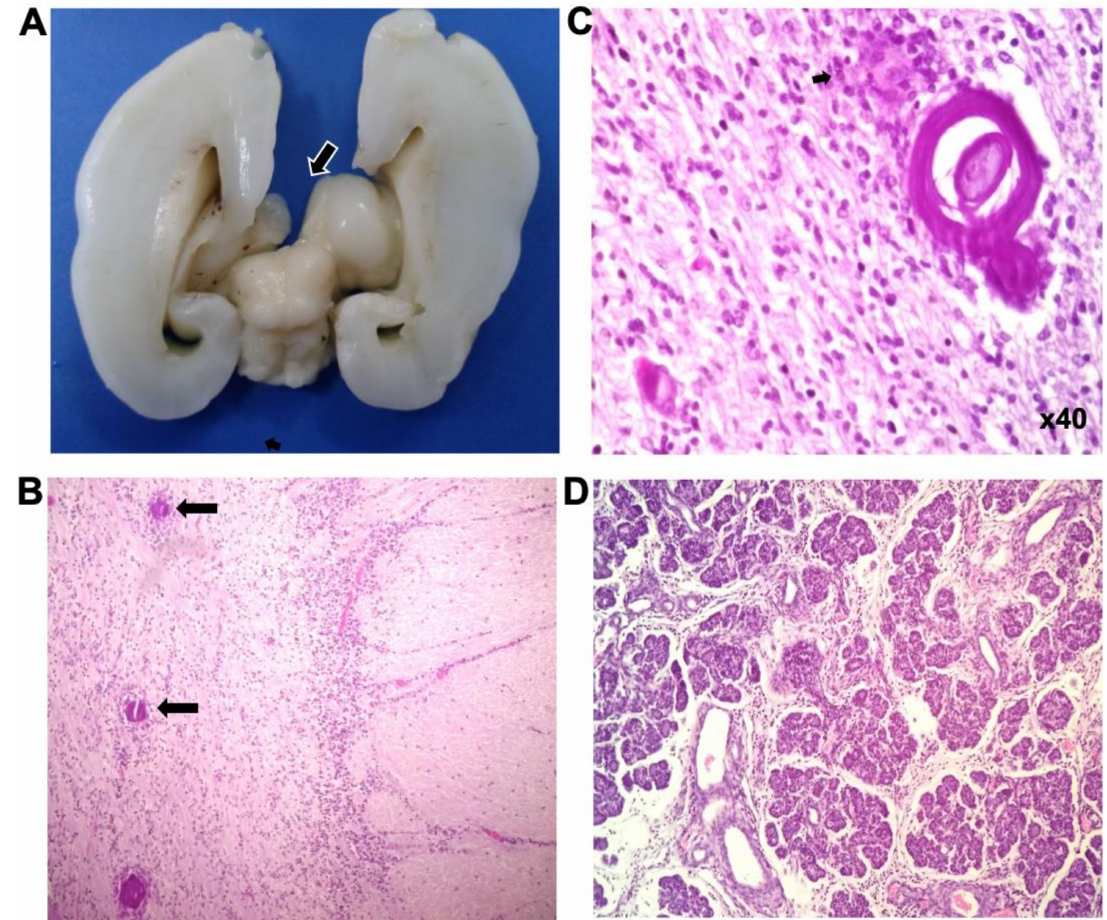
Figure 3. Anatomopathological findings of case 2. ( A ) Brain section showing corpus callosum agenesia. ( B ) Histological analysis of brain sections revealed brain parenchyma with disorganized cortex layers, and zones with laminated microcalcifications (arrows). ( C ) Neuropile with concentric calcospherites. ( D ) Pancreas with absence of Langerhans’ islets. (H&E